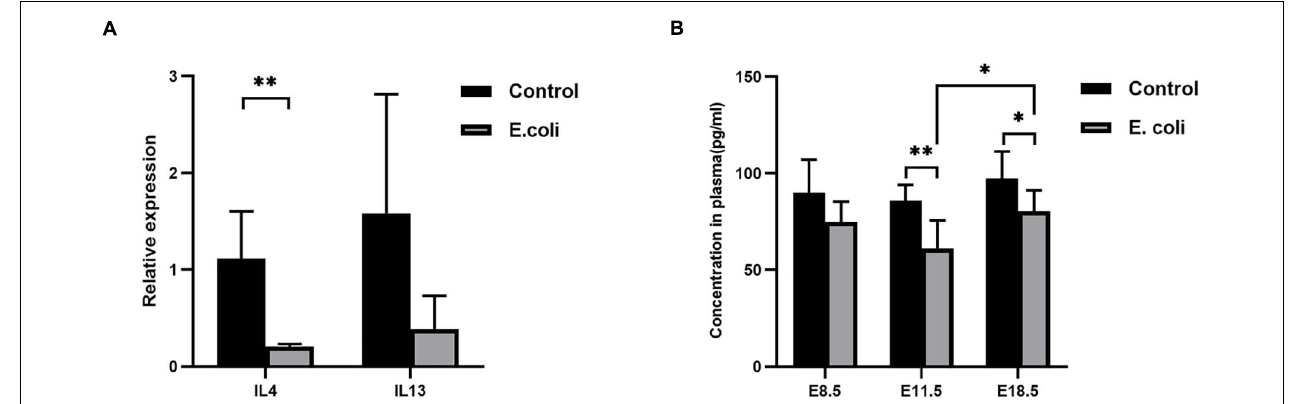
FIGURE 4 | Validation of screening results of differentially expressed genes. (A) Validation of screened differentially expressed genes by PCR. Four samples of each group were used. The experiment was performed in triplicate and repeated two times. (B) The concentration of IL-4 expression in the blood of mice in the study ( E. coli ) group at E8.5, E11.5, and E18.5 ( n = 6). Data are shown as mean ± standard deviation. Unpaired t -test was used for two-group comparisons. ∗ P < 0.05, ∗∗ P <